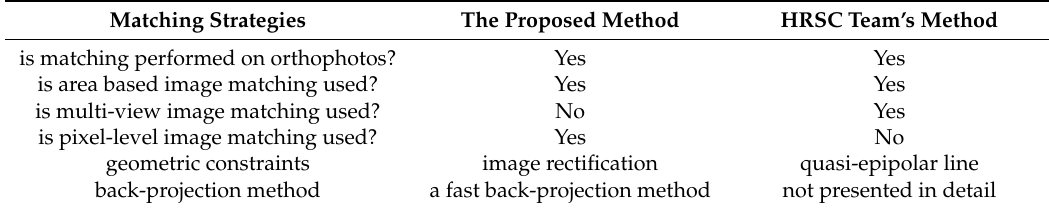
Table 4. Matching strategies comparison between the proposed method and the HRSC team’s